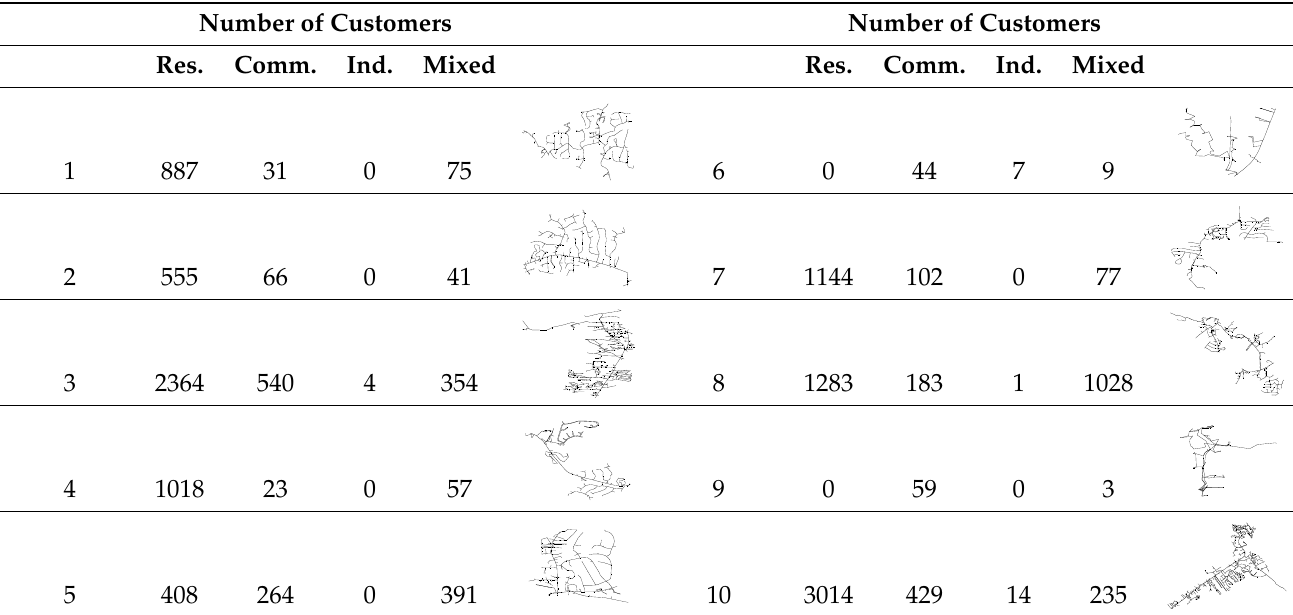
Table 1. Feeder Customer Details.